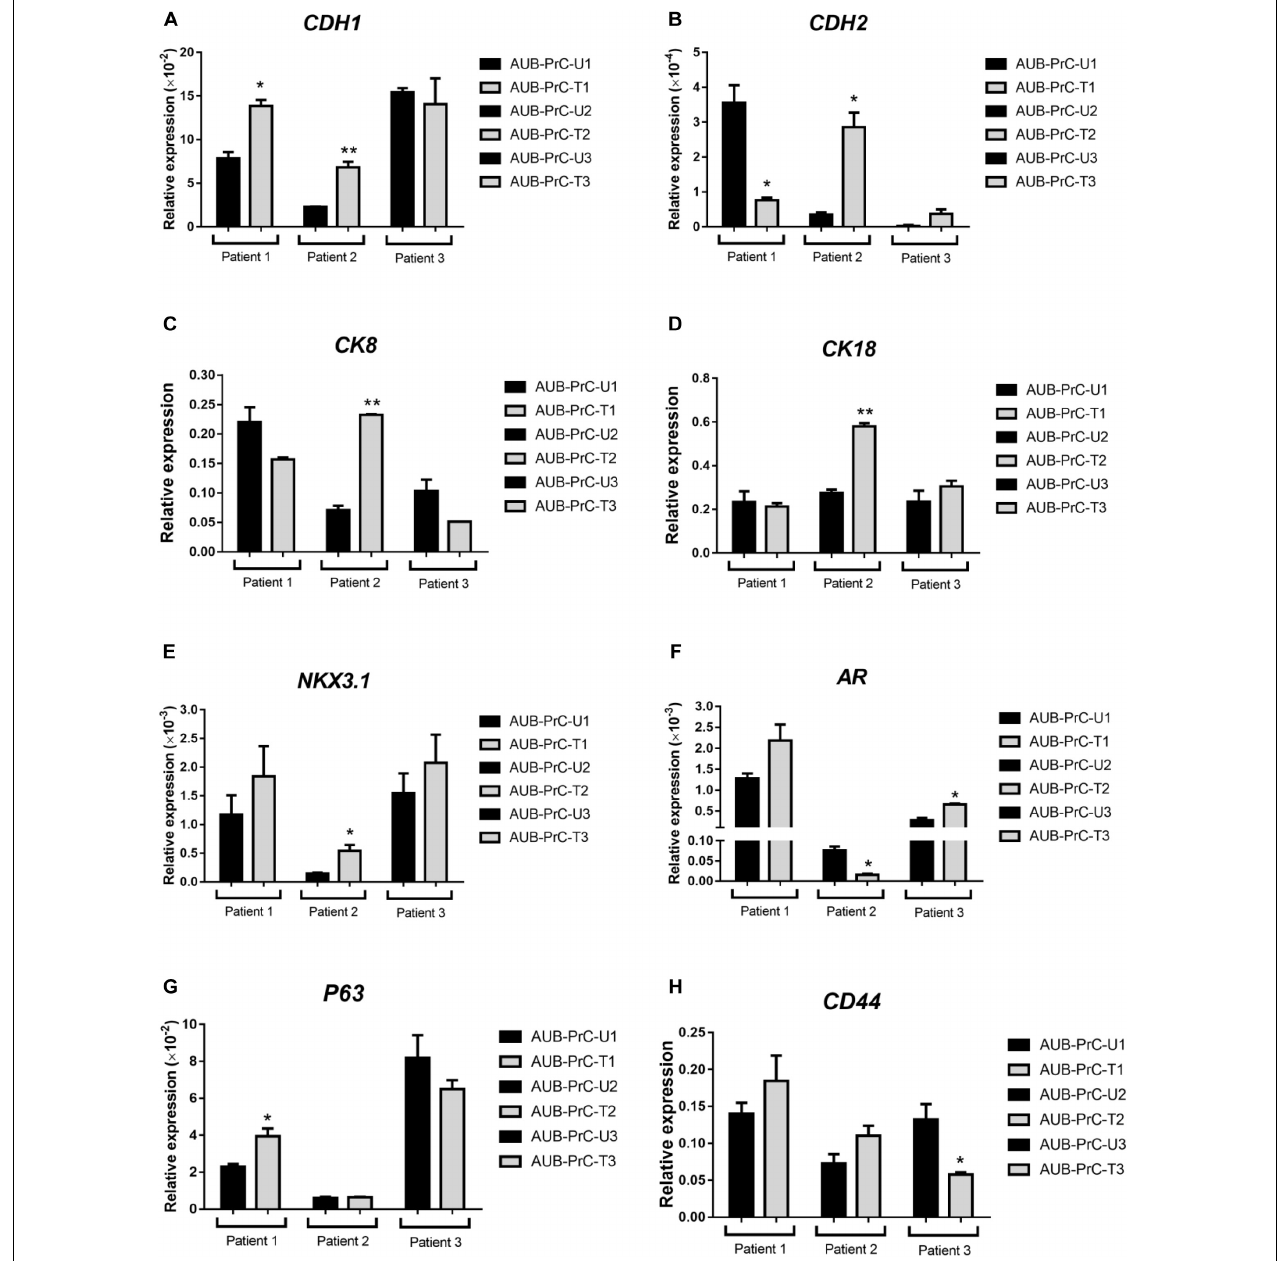
FIGURE 3 | Expression of different prostate epithelial lineage and stem cell markers determined using qRT-PCR analysis. qRT-PCR expression analysis depicted aberrations in epithelial cell markers ( A: CDH1 and B: CDH2 ), prostate luminal epithelial markers ( C: CK8 and D: CK18 ), basal epithelial cell marker ( E: NKX3.1 ), stem cell markers ( G: P63 basal stem cell marker and H: CD44 ), and other markers know to aberrated in PCa ( F: AR ). For each patient {patient 1 with Grade Group 5 [Gleason Score 9(5 + 4)]; patient 2 with Grade Group 3 [Gleason Score 7(4 + 3)]; patient 3 with Grade Group 2 [Gleason Score 7(3 + 4)]; patients characteristics in Supplementary Table S1 }, reactions were performed in biological duplicates and expressions of individual genes was normalized to the house keeping gene GAPDH . Data were plotted relative to the unaffected cells (AUB-PrC-U) for each patient. Relative expression value are presented as means + SD (two technical replicates) (* P < 0.05; ** P < 0.01; by Student’s t